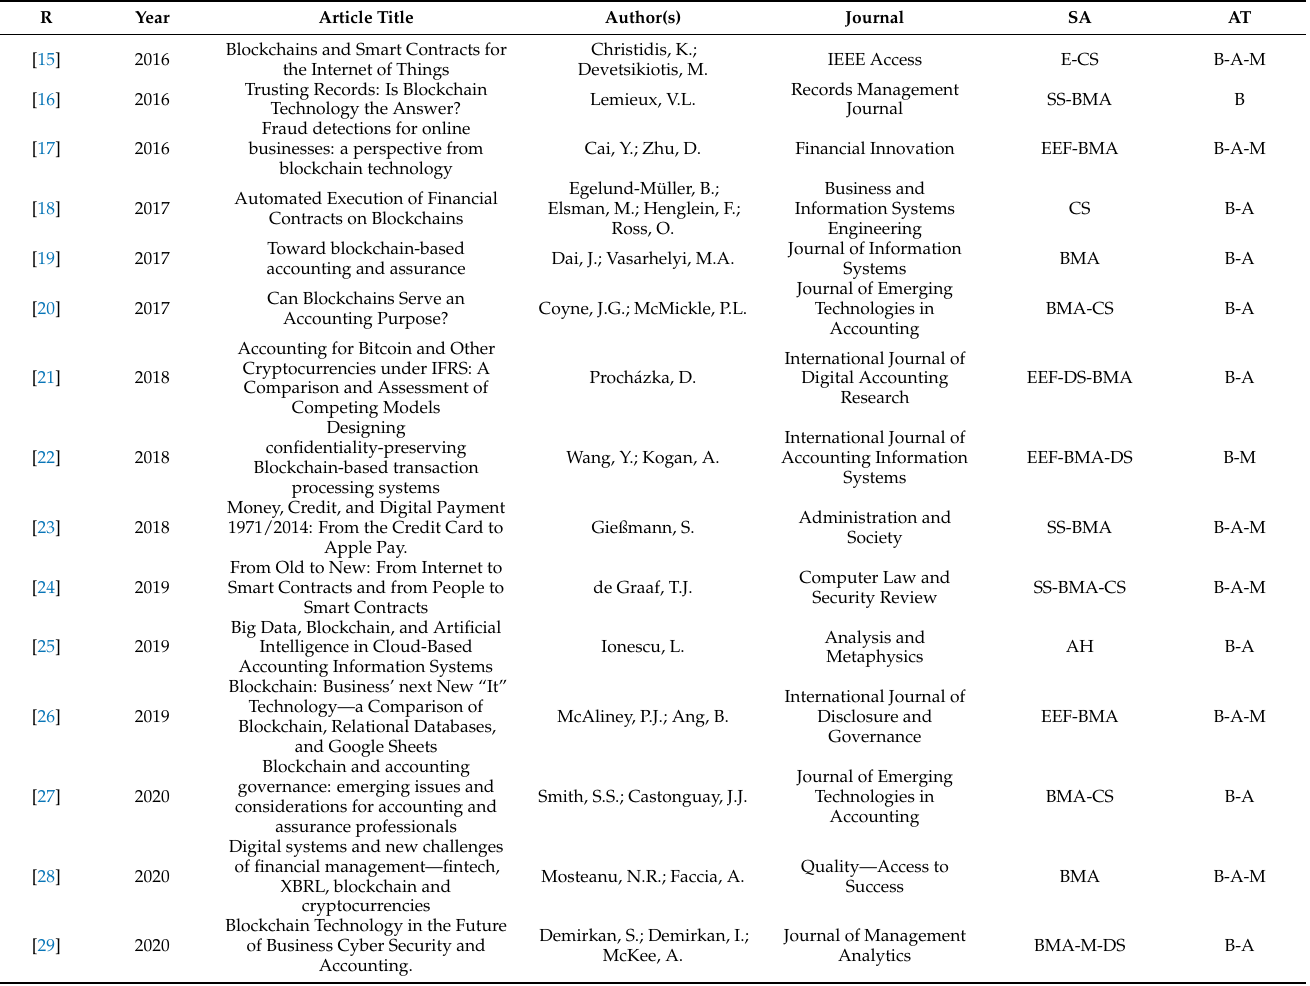
Table 1. Main articles used to define the objective and variables of the